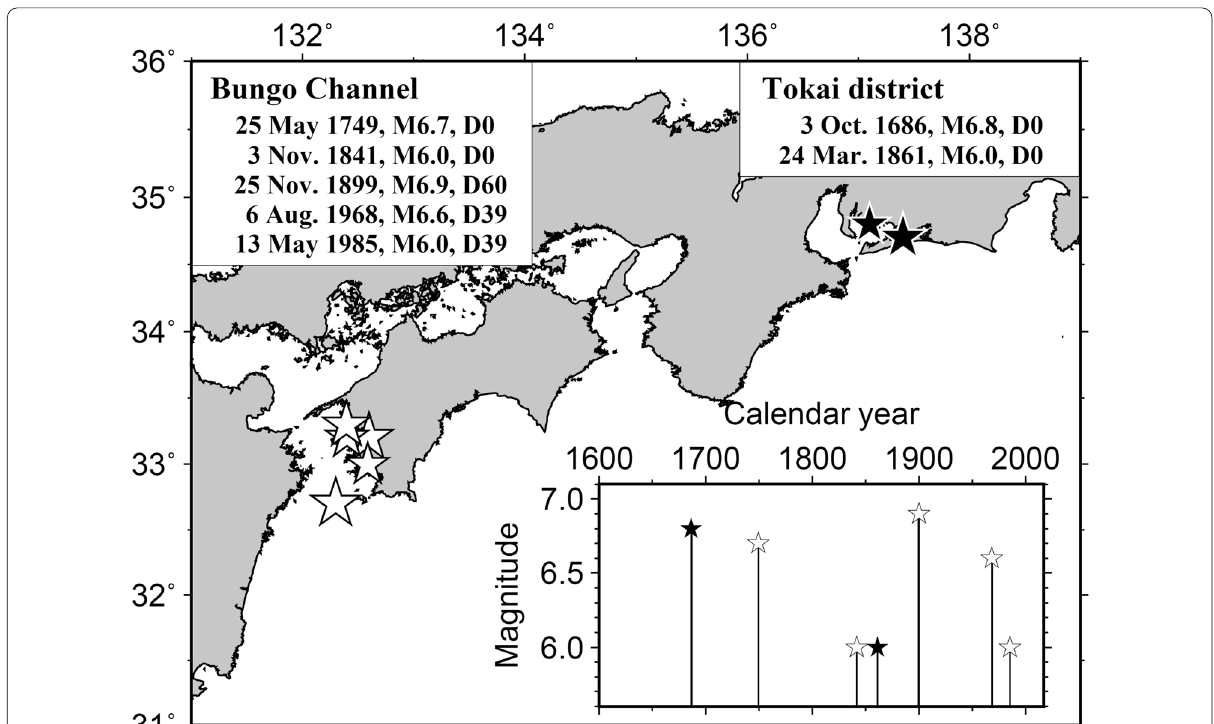
Fig. 8 Epicentral distribution and magnitude diagram of M 6-class earthquakes in the Tokai district (solid stars) and the Bungo Channel (open stars) during 1600–2015. D Indicates the depth of an